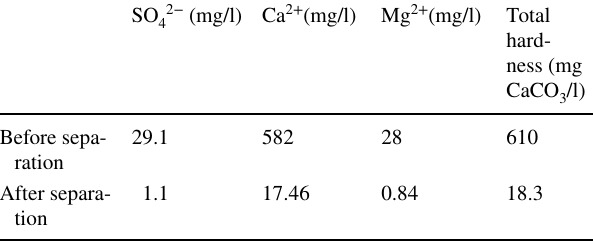
Table 4 The ion concentrations and total hardness of Gachsaran brackish water before and after filtration by the optimum membrane (M5)